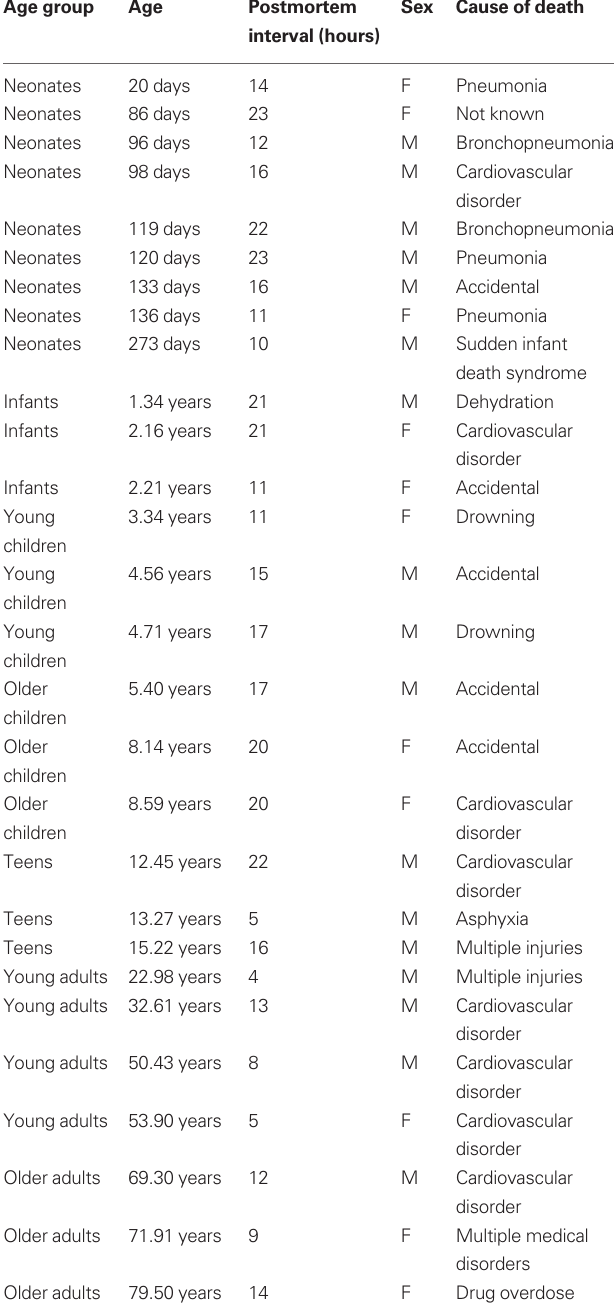
Table 1 | Human tissue samples. The age group, age, postmortem interval and cause of death for each of the human cortical tissue